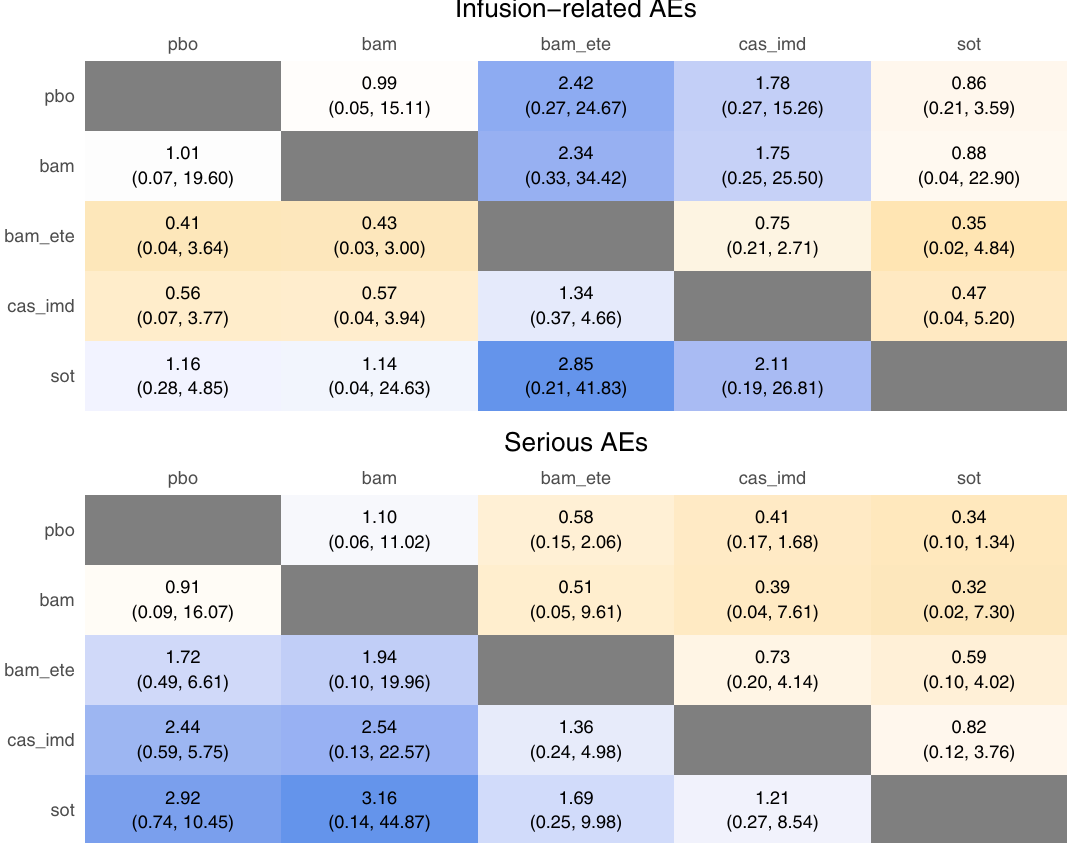
Figure 6. NMA results showing relative risks for all pairwise comparisons for safety outcomes (posterior median and 95% credible interval). Notation: pbo: placebo; bam, bamlanivimab; bam_ete; bamlanivimab/ etesevimab; cas_imd, casirivimab/imdevimab; sot, sotrovimab. For each pairwise comparison, posterior median and 95% credible interval are shown for the estimated relative risk. Values of greater than one indicate that the given event is more frequent for the intervention (column name) than the comparator (row name). A double asterisk (**) in a given cell indicates that the corresponding comparison is statistically significant at the nominal 95% confidence level (i.e. without correction for multiple